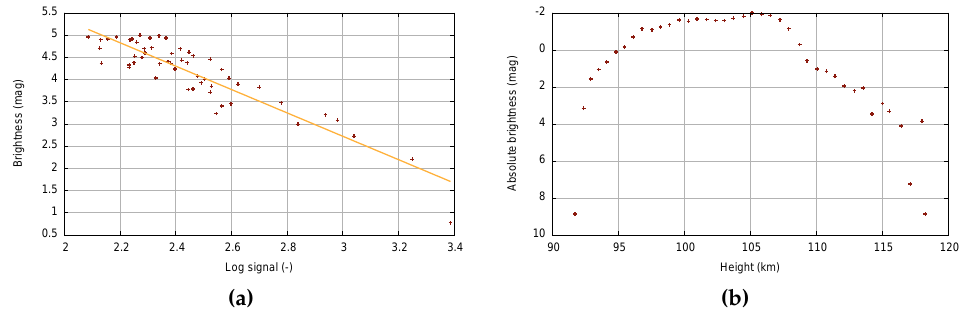
Figure 8. ( a ) Calibration curve; ( b ) Light curve of detected meteor.